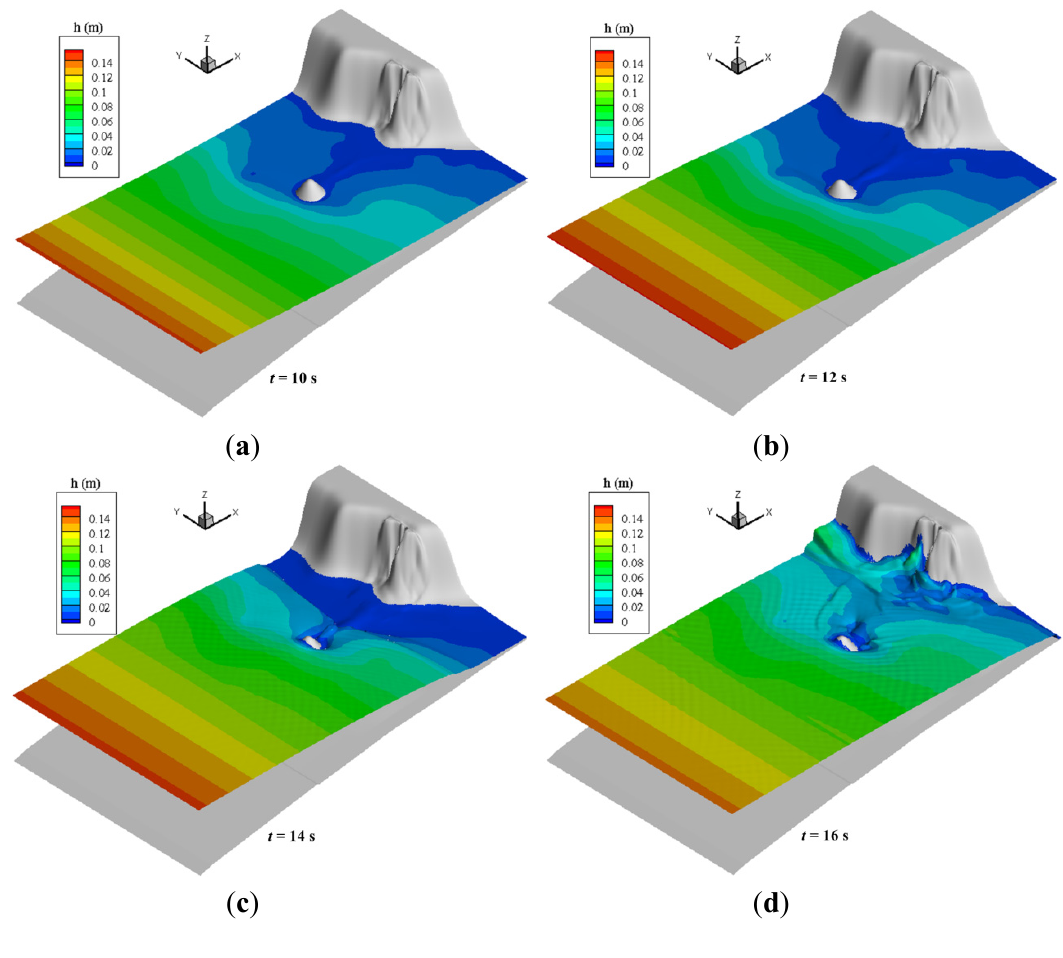
Figure 3. Three-dimensional view of bed elevation and the locations of the three gauges. Bed elevation is presented in the colored contours and dots represent three recoded gauges. Red color represents high land and blue represents sea